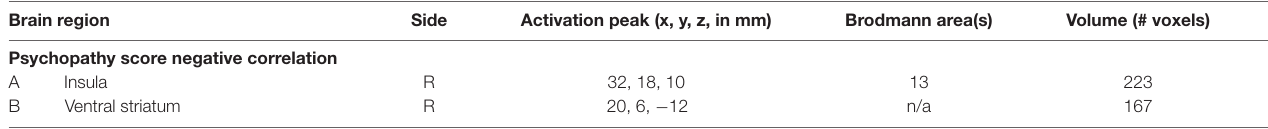
Brain region Side Activation peak (x, y, z, in mm) Brodmann area(s) Volume (# voxels) Psychopathy score negative correlation